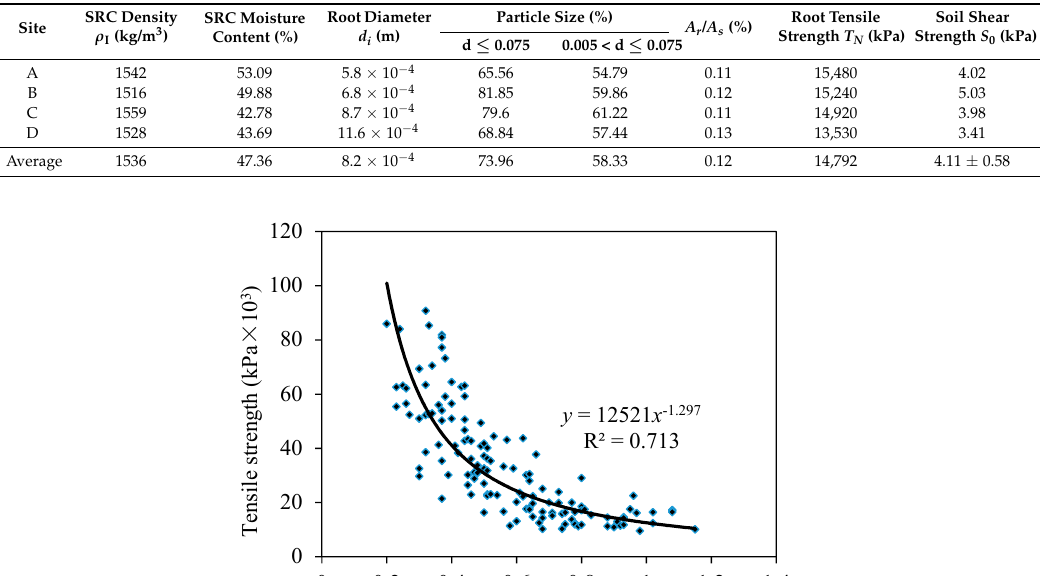
Table 2. Physical parameters of soil-root composite (SRC), soil, and roots in the undisturbed samples.